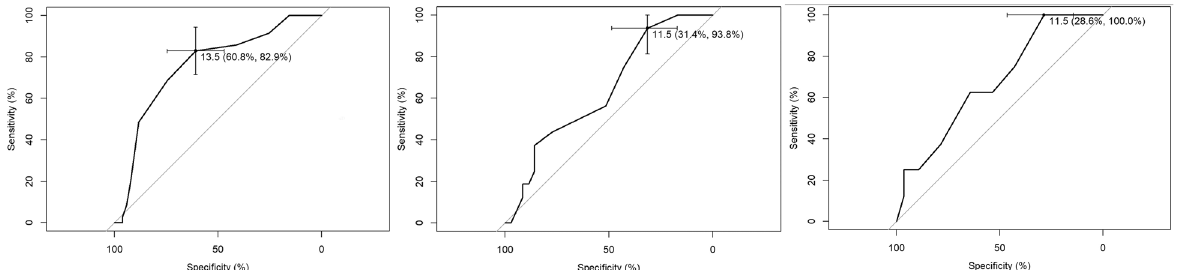
Figure 5. ROC curve and Youden’s index for pre-treatment intraocular pressure (IOP) and outcome increase in pressure > 30 mmHg, from left to right for the aflibercept prefilled syringes (PFS), aflibercept vials and ranibizumab PFSs.